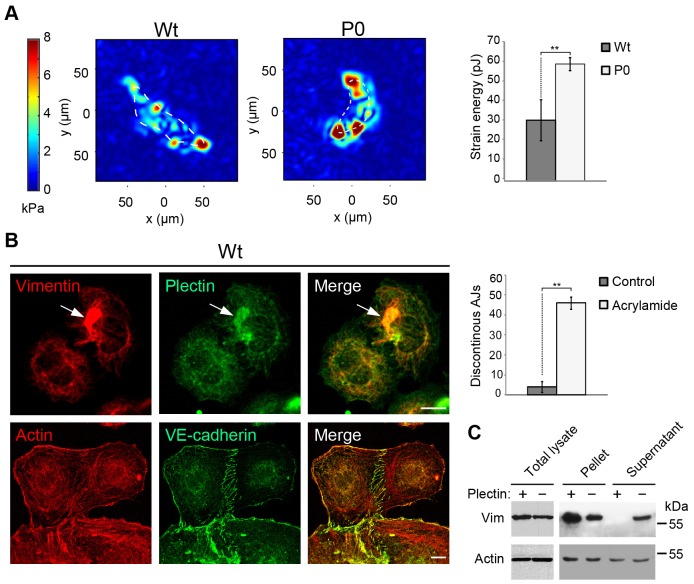
Traction measurements and cytoskeletal alterations in P0 cells. (A) Representative traction maps of Wt and P0 cells are shown in the left panels. Traction maps were computed from the displacement field of fluorescent beads embedded in collagen-coated polyacrylamide gels (before and after treatment with cytochalasin D), using FTTC. Colours in panels show the magnitude of the tractions in kPa (see colour bar). The bar graph shows the calculated strain energy from traction measurements. 57 Wt and 107 P0 cells were analysed from three independent experiments. **P<0.01 (Student's t-test). (B) Wt cells were seeded onto plates for 1 h in the presence of 6 mM acrylamide and processed for double immunofluorescence microscopy using antibodies to vimentin and plectin (upper row), or actin and VE-cadherin (lower row). The bar graph shows the quantitative evaluation (200 junctions per treatment, two independent experiments) of the number of cell–cell junctions exhibiting non-linear (‘zig-zag’) morphology along with actin stress fibres extending to the junctions (discontinuous AJs). Arrow (upper row), collapsed vimentin filaments colocalizing with plectin. Scale bars: 10 µm. **P<0.01 (Student's t-test). (C) Cells were harvested and either lysed using SDS buffer (total lysate), or incubated with detergent-extraction buffer, followed by centrifugation to yield detergent-insoluble pellets and detergent-soluble supernatants. Samples were analysed by immunoblotting using antibodies to the indicated proteins. Vim, vimentin.